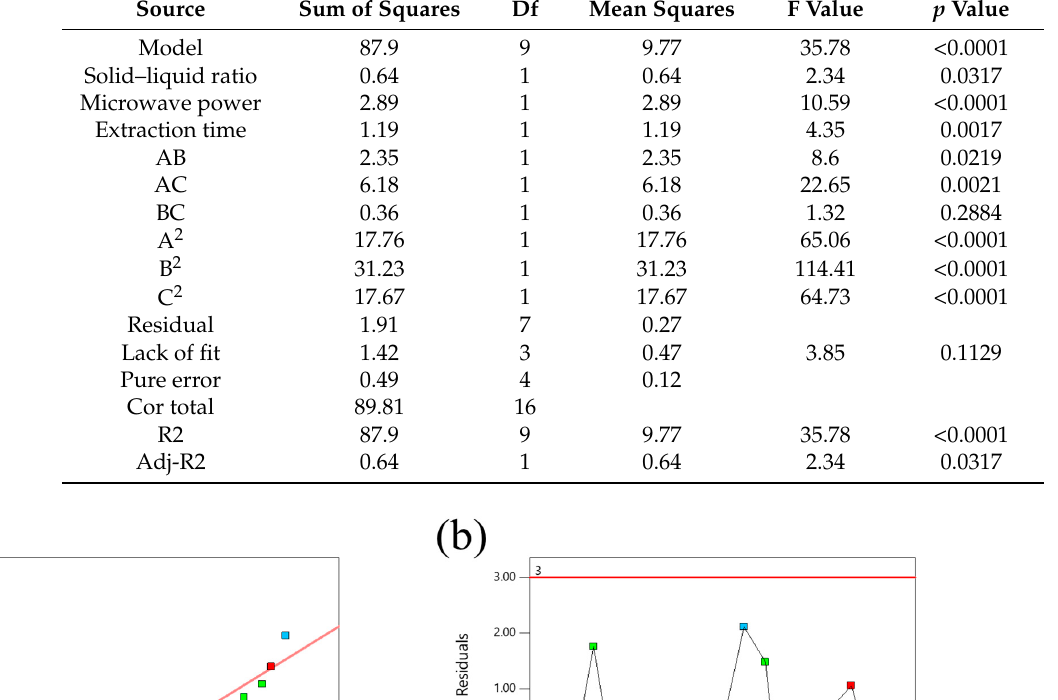
Table 2. ANOVA for the response surface model.